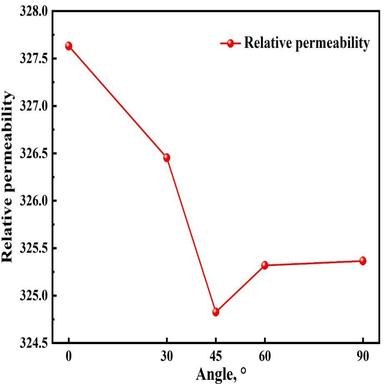
Relative permeability under different angles between grain boundary and magnetic field.